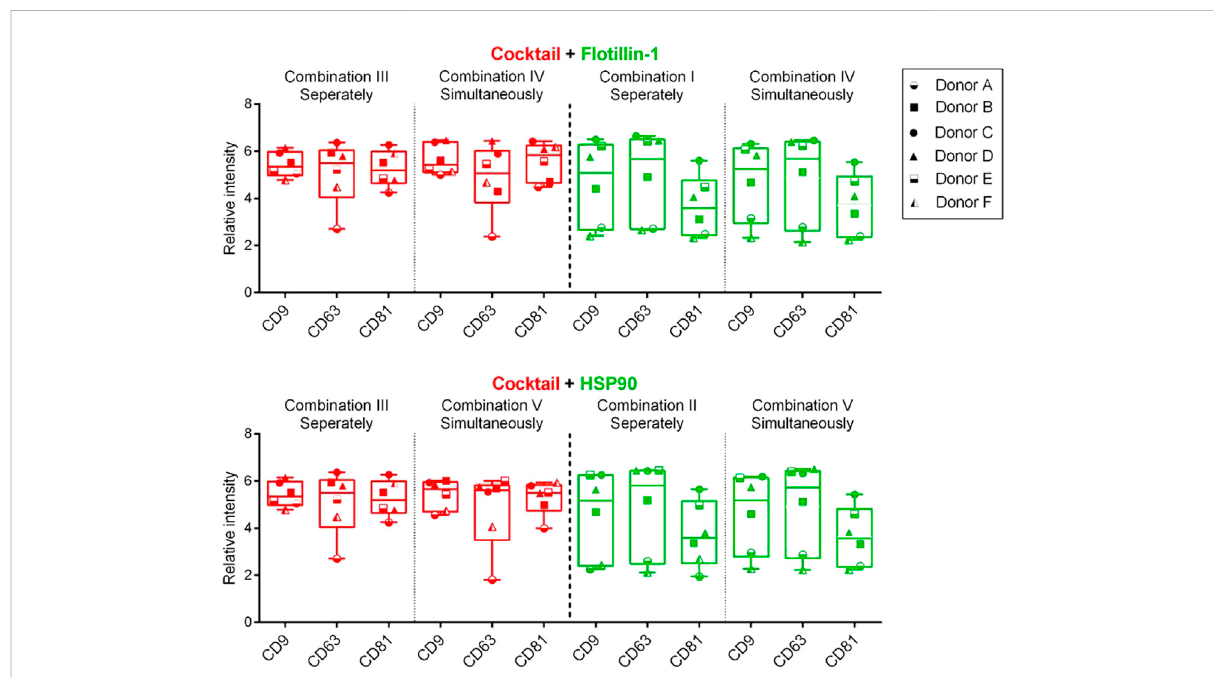
FIGURE 4 Box and whisker plot (min to max) of the background-corrected intensities obtained from spots with captured sEVs by CD9, CD63, and CD81antibodies(Y-axis).Dataincludecompiledresultsfromsixdonors(A – F)and fi vedifferentcompositions(I – V)ofdetectionantibodies.Acocktail of murine antibodies, CD9, CD63, and CD81, or rabbit antibodies, fl otillin-1 and HSP90, was measured separately or simultaneously. Cy5-labeled streptavidin (red) and Cy3-labeled IgG (green) were applied for detection. p -values, between separate and simultaneous measurements, were calculated using the Wilcoxon matched-pairs signed rank test (all p -values > 0.05).